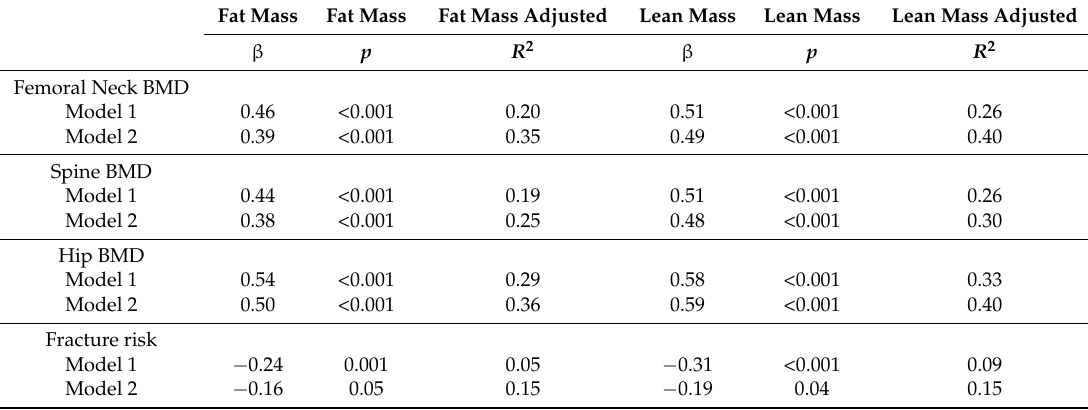
Table 1. Association between bone mineral density (BMD) or fracture risk as the dependent variable, and body composition parameters as the independent variables, using two different models of multivariate regression. Table reproduced with permission [35]. Fat Mass Fat Mass Fat Mass Adjusted Lean Mass Lean Mass Lean Mass Adjusted β p R 2 β p R 2 Femoral Neck BMD Model 1 0.46